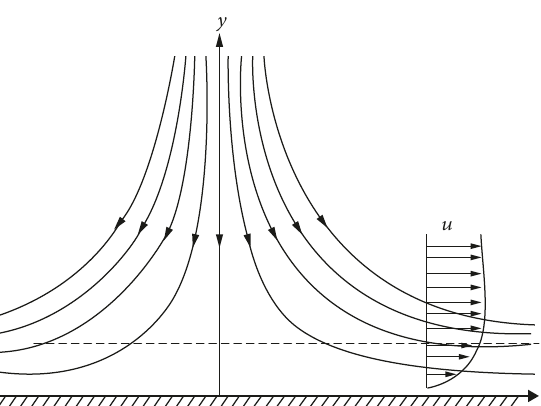
Figure 3: Axisymmetric